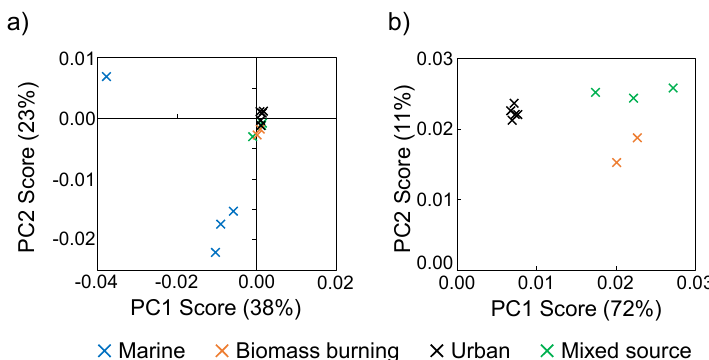
Figure 5. Aerosol WSOM ( a ) PC1 and PC2 scores for PCA of full 1 H NMR spectra of marine, mixed source, biomass burning, and urban aerosols and ( b ) PC1 and PC2 scores for PCA omitting marine aerosols. The amount of variation explained by each PC is indicated in parentheses on each axis.